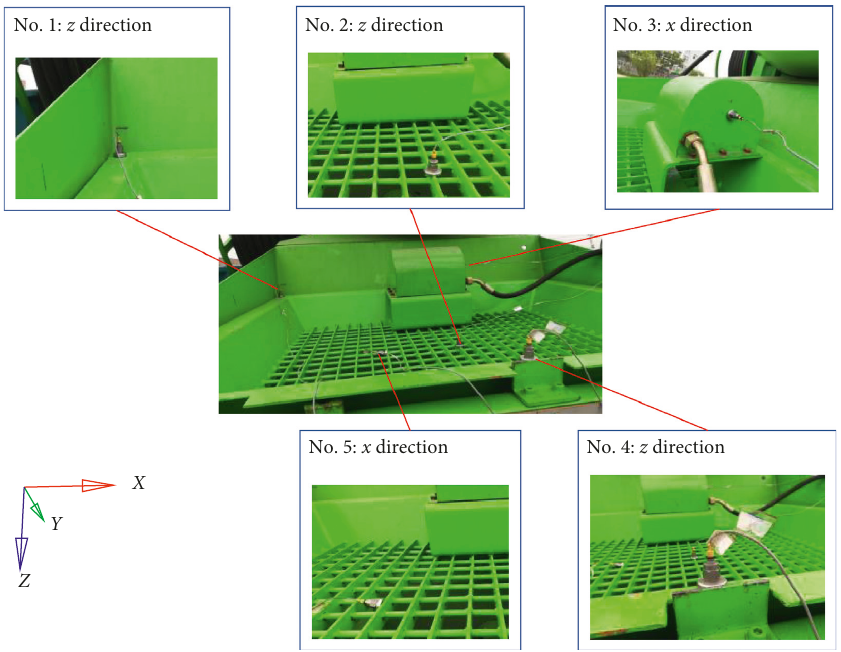
Figure 4: The positions of five